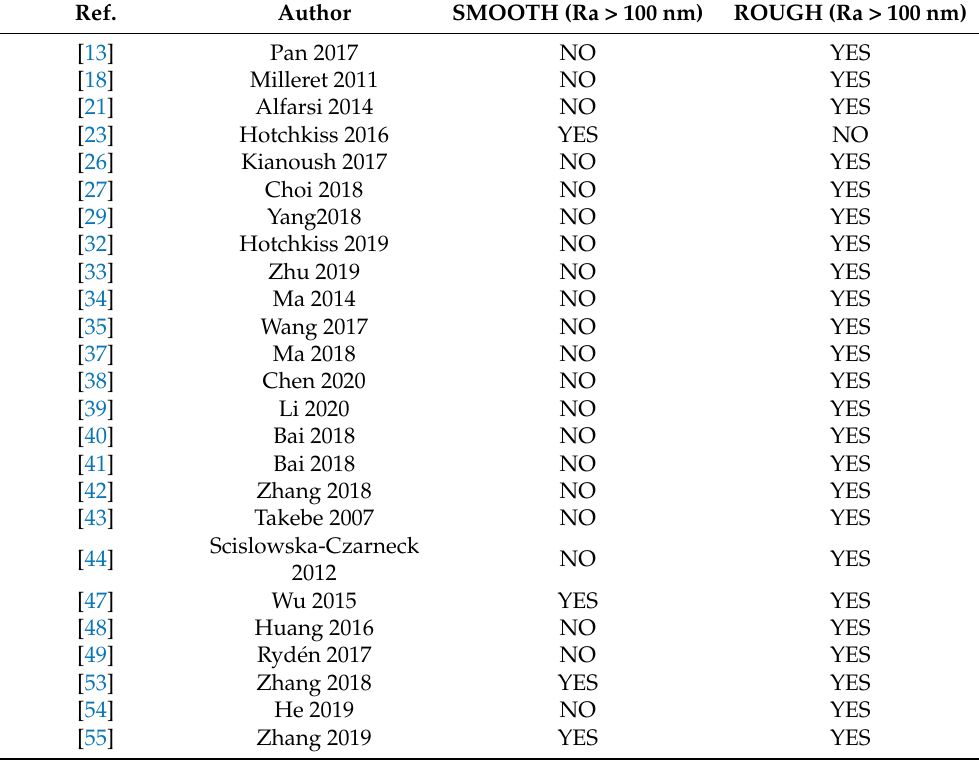
Table 3. Morphological changes associated with an M2 macrophage phenotype were grouped according to whether this occurred on either a ‘smooth’ or ‘rough’ titanium surface. To facilitate this, given the multitude of ways the surfaces were prepared, a single roughness (Ra) value was used to group the data. M2 phenotype was significantly associated with attachment to the rough surfaces (chi-square statistic with Yates correction 29.301, p -value <